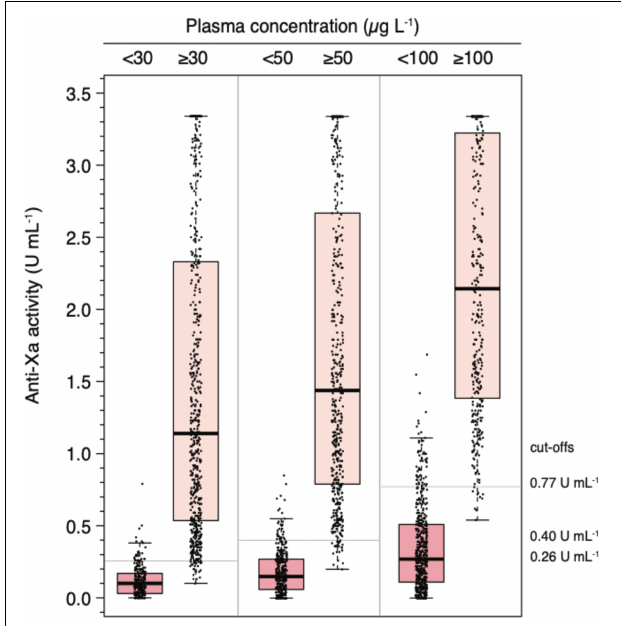
FIGURE 3 | Distribution of universal, heparin-calibrated anti-Xa measurements for the measurement of rivaroxaban, apixaban, and edoxaban drug concentrations in clinical practice ( n = 845). Box plot illustrating the distribution of measurement (median, interquartile range, minimum, maximum) at clinically relevant cut-off levels (above and below 30, 50, and 100 µ g L − 1 ).